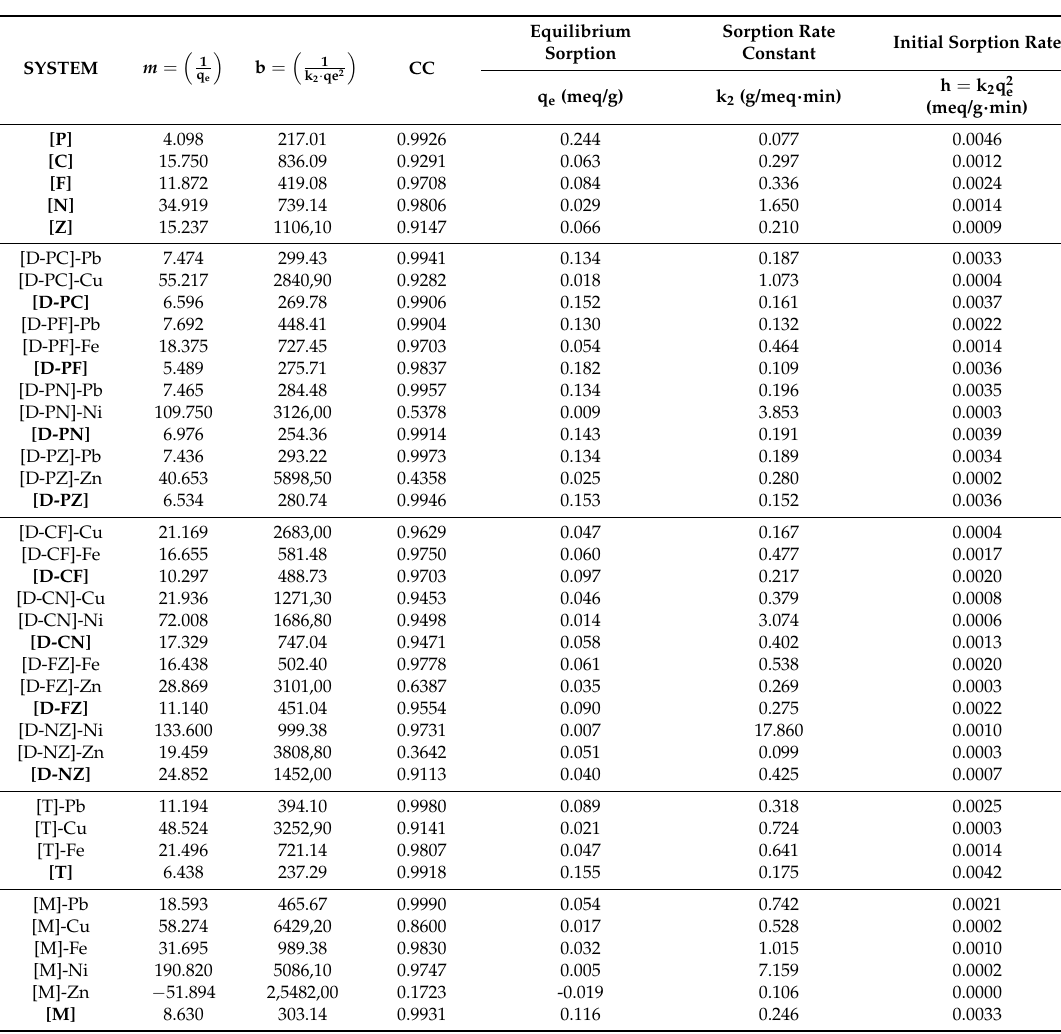
Table 4. Pseudo-second-order